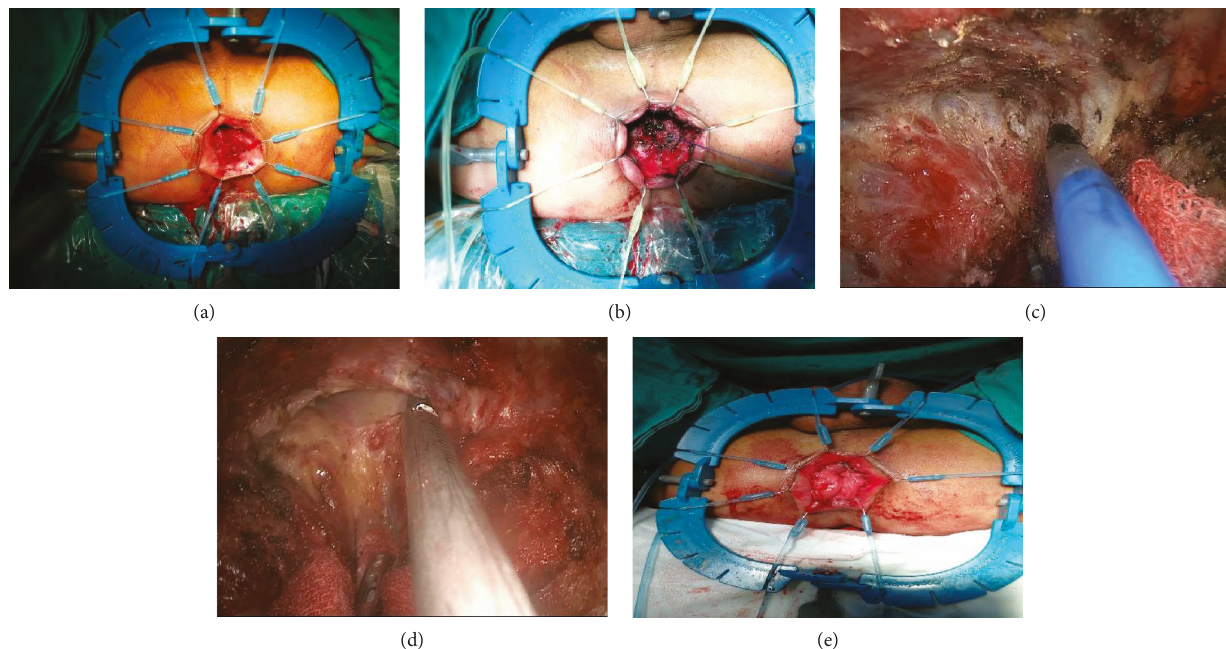
Figure 1: Procedure of TAES. (a) Expose the anorectum. (b) Purse strings to occlude rectal lumen. (c) Free lesions. (d) Transabdominal groups meeting with transanal groups. (e) Hand-sewn